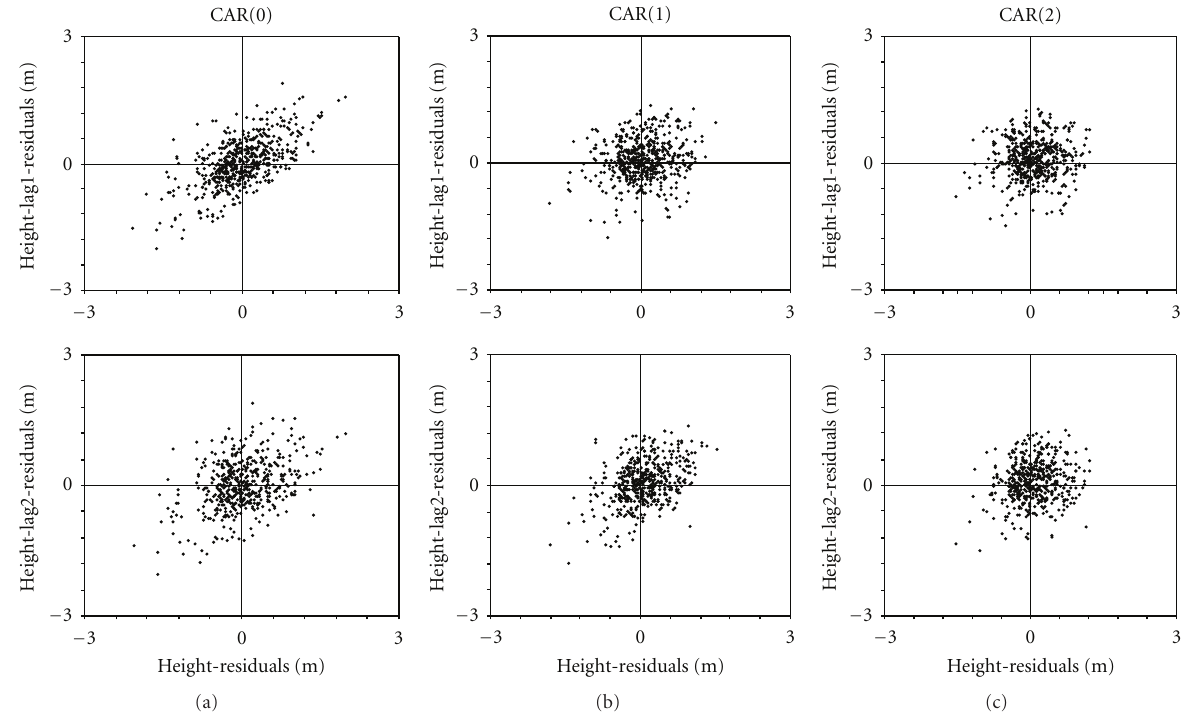
Figure 2: Height-lag1-residuals and height-lag2-residuals versus height-residuals for model M6 fitted without considering the autocorrelation parameters (a), and using continuous-time autoregressive error structures of first and second order (b and c, resp.).